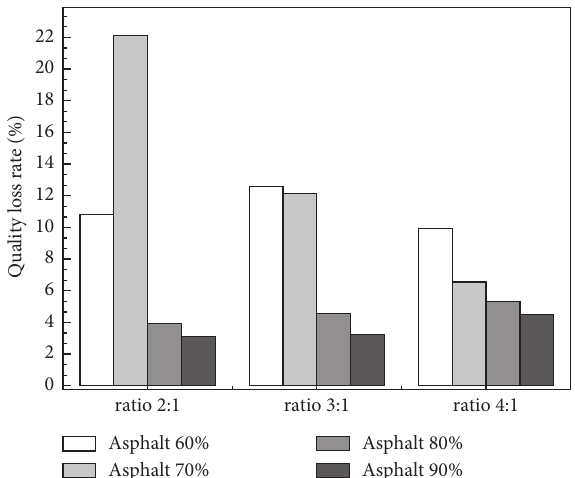
Figure 13: The mass loss rate of cured products after photothermal